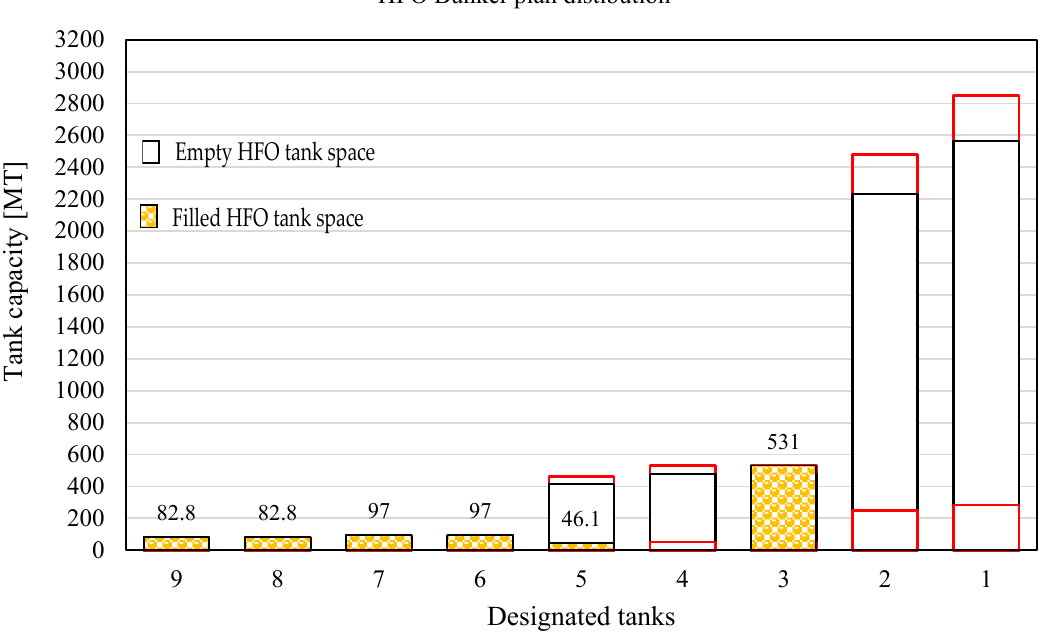
Figure 4. HFO bunker condition before bunker loading for the first example.